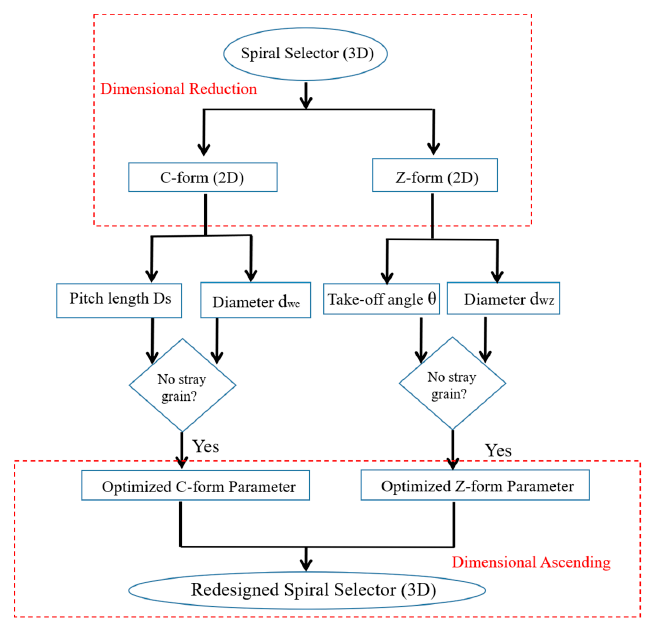
Figure 2. Figure 2. The flow chart of developing a high-efficient grain selector with the reduction dimensional method. Figure 2. The flow chart of developing a high-efficient grain selector with the reduction dimensional Figure 2. The flow chart of developing a high-efficient grain selector with the reduction dimensional Figure 2. The flow chart of developing a high-efficient grain selector with the reduction dimensional Figure 2. The flow chart of developing a high-efficient grain selector with the reduction dimensional Figure 2. The flow chart of developing a high-efficient grain selector with the reduction dimensional Figure 2. The flow chart of developing a high-efficient grain selector with the reduction dimensional Figure 2. The flow chart of developing a high-efficient grain selector with the reduction dimensional Figure 2. The flow chart of developing a high-efficient grain selector with the reduction dimensional method. method. method. method. method. method. method.